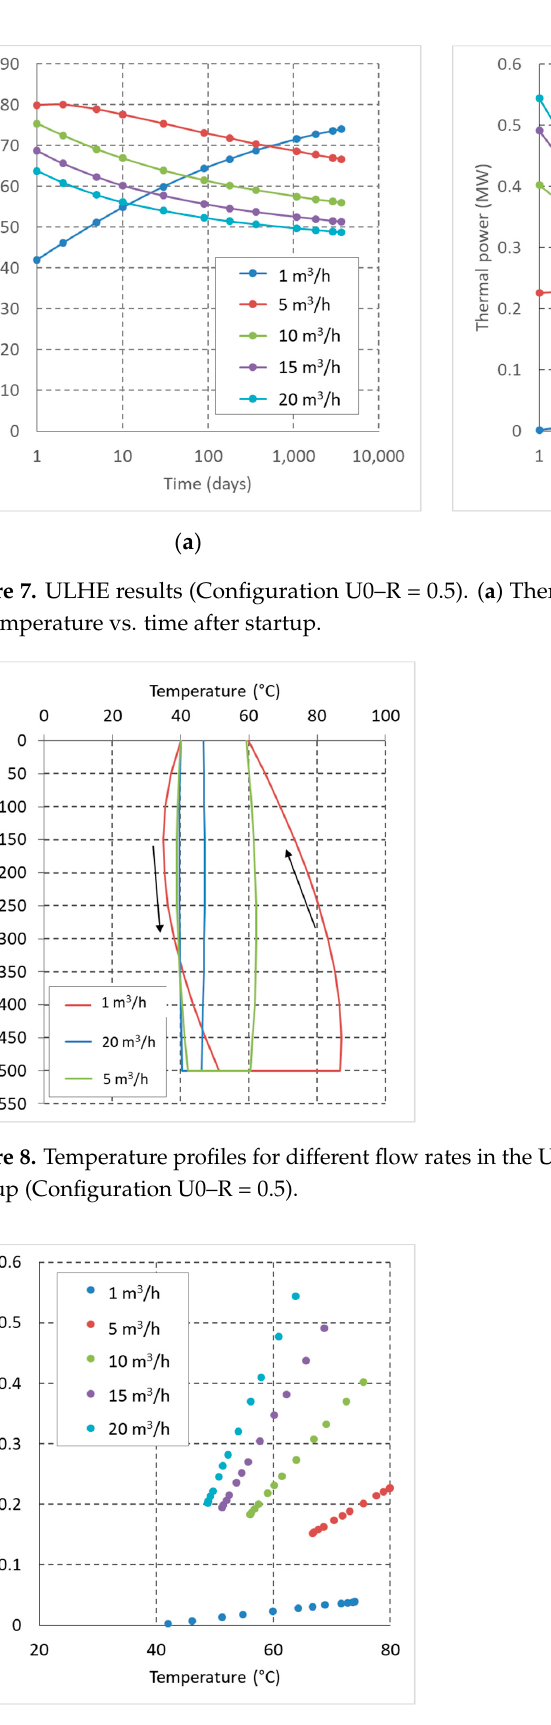
Figure 9. Thermal power vs outlet temperature for the ULHE (Configuration U0–R =